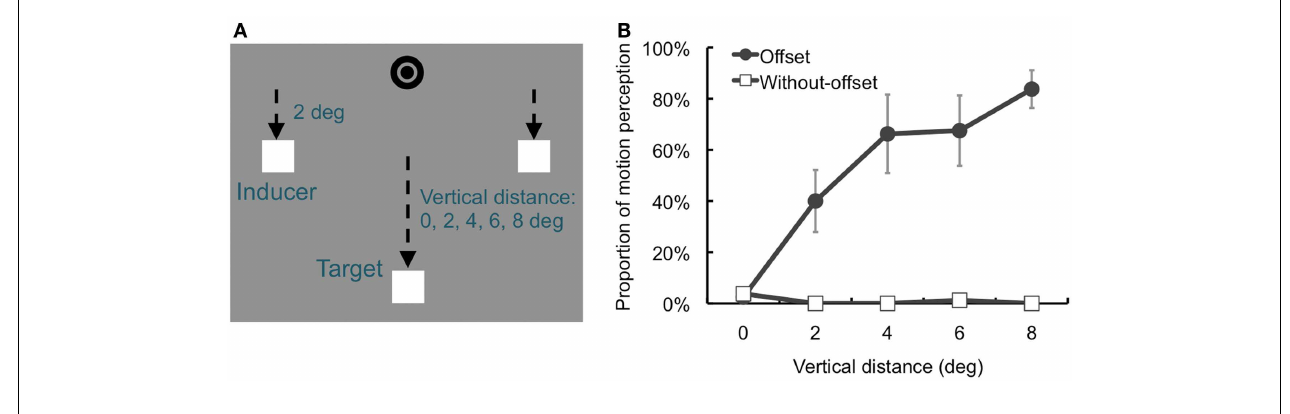
the fixation point). (B) Results. Proportion of illusory motion perception perceived for the target increased with the increment of the target’s eccentricity. Error bars denote standard errors of the mean ( N =